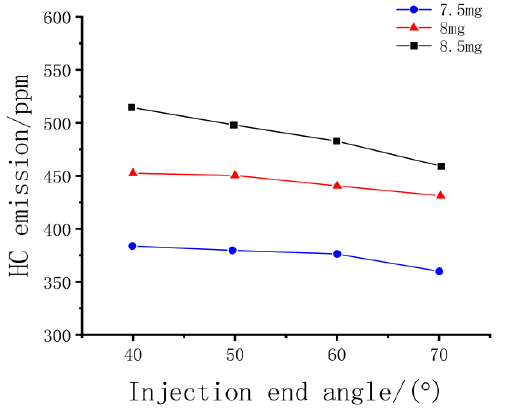
Figure 40. Effect of the injection parameters on HC emissions.